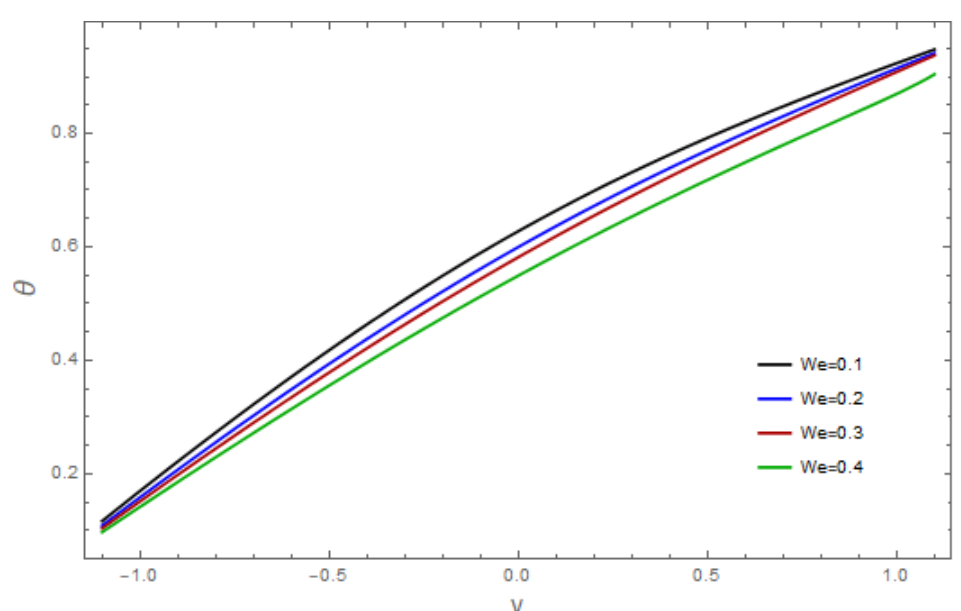
Figure 16. Effect of 𝑊𝑒 on 𝜃 .